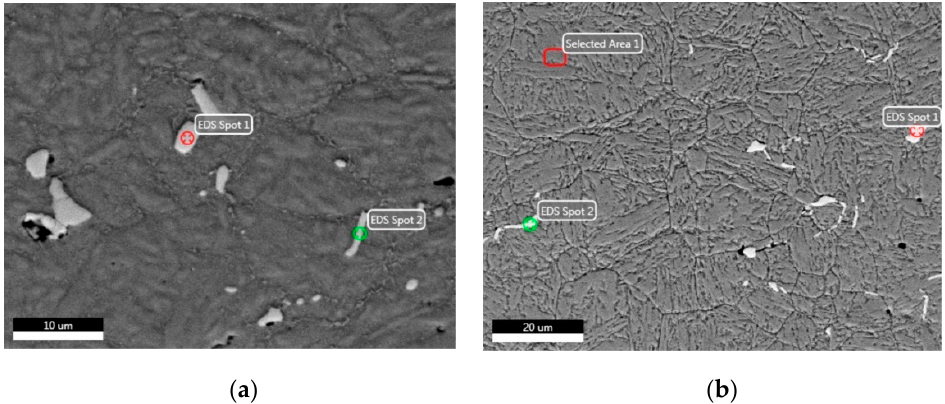
Figure 9. EDS analysis of X6CrNiMoVNb11-2 steel before and after heat treatment: ( a ) EDS of the initial as-rolled X6CrNiMoVNb11-2 steel; ( b ) EDS after quenching (at 1040 °C, oil cooling) and tempering (at 650 °C, oil cooling) processes.